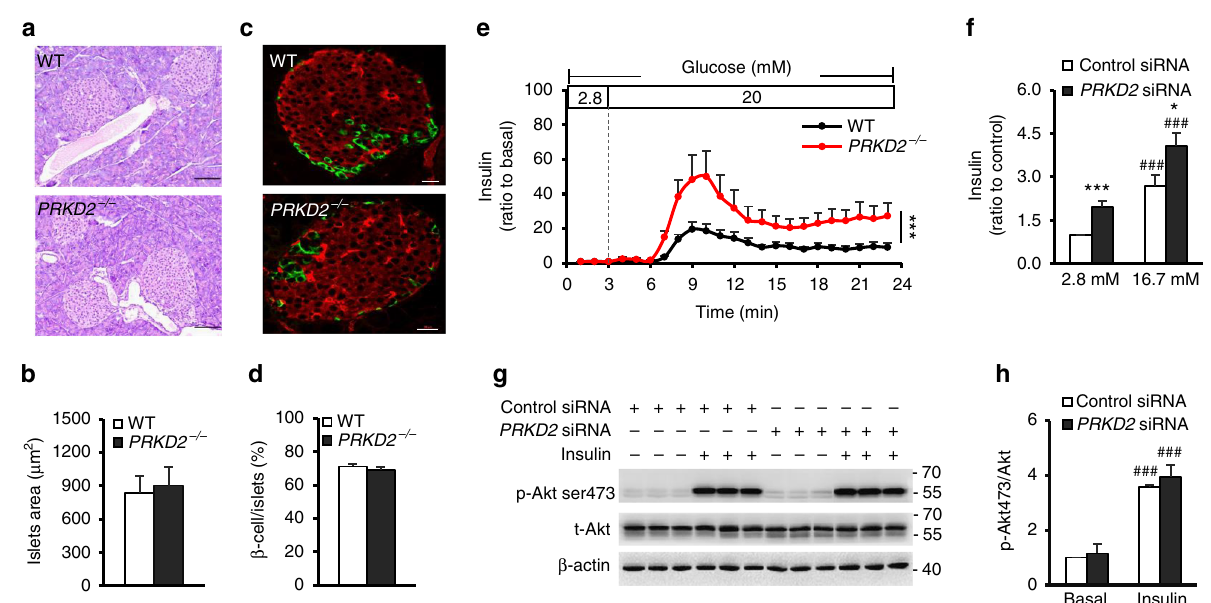
Fig. 5 PRKD 2 de fi ciency increases insulin secretion in isolated islets and β cells. a , b Representative pancreatic images of hematoxylin and eosin (HE) staining ( a ) and statistics ( b ) showing that PRKD2 -knockout in mice did not affect islet morphology and size at 14 weeks of age. Scale bar = 100 μ m (WT, n = 8; PRKD2 − / − , n = 6). c , d Representative images of immuno fl uorescence staining for insulin and glucagon in pancreatic islets ( c ) and statistics ( d ) showing that PRKD2 -knockout did not affect the number of β -cells within islets. Scale bar = 20 μ m (WT, n = 6; PRKD2 − / − , n = 5). e Time-courses of glucose-stimulated insulin secretion in islets isolated from PRKD2 − / − (red) and WT (black) mice. *** p < 0.001, WT vs PRKD2 − / − , by two-way ANOVA ( n = 10/group). f Insulin secretion in control and PRKD2 -knockdown Ins-1 cells. * p < 0.05, *** p < 0.001, control siRNA vs PRKD2 siRNA; ### p < 0.001, 2.8 vs 16.7 mM glucose ( n = 10/group). g , h Representative western blots of Akt ser473 phosphorylation ( g ) and statistics ( h ) in control and PRKD2 -knockdown Ins-1 cells. ### p < 0.001, basal vs insulin ( n = 8/group). All data are represented as mean ± SEM, the signi fi cant difference between groups was assessed by the Student ’ s t